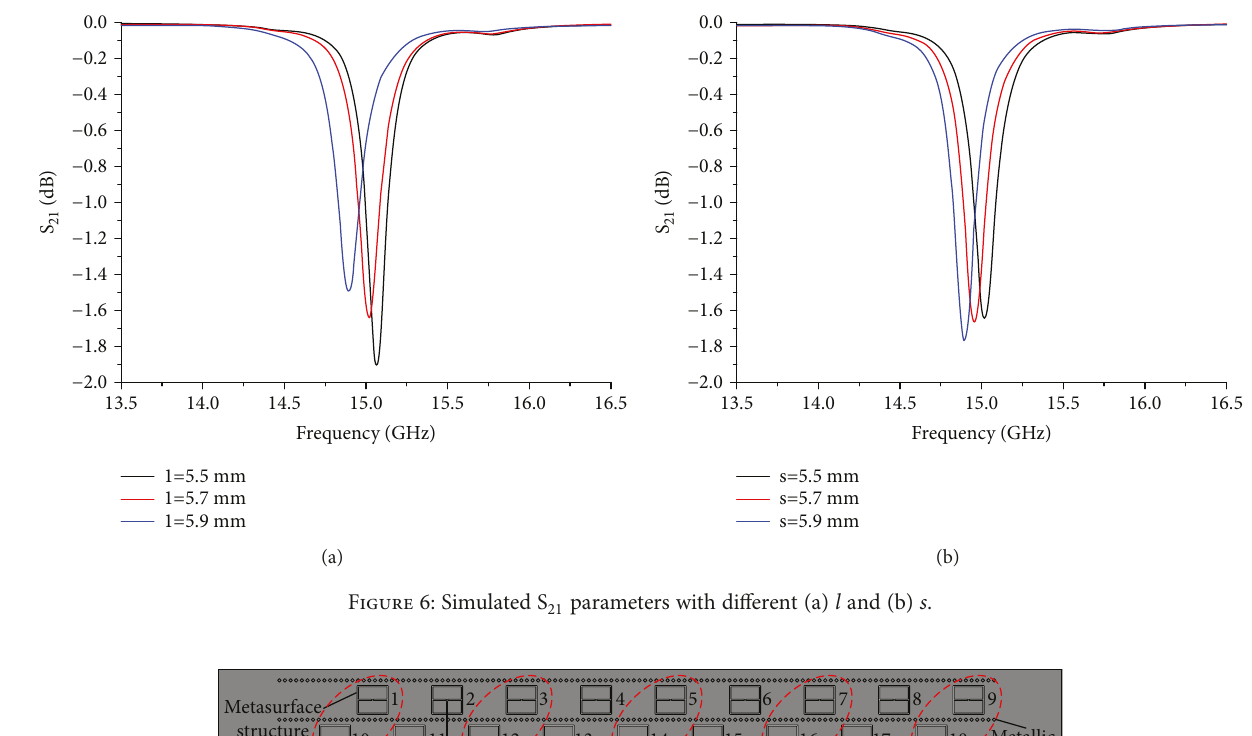
parameters with di ff erent (a) l and (b) s . 21